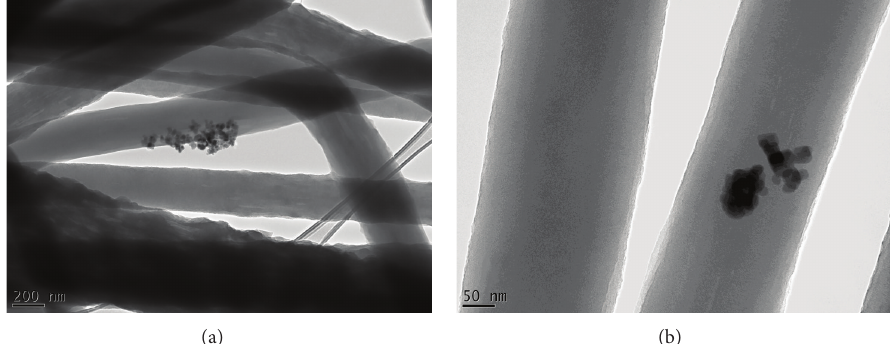
Figure 2: TEM images of PVdF/5 wt% Fe 3 O 4 fibres. (a) Protruding Fe 3 O 4 nanoparticle agglomeration. (b) Internal Fe 3 O 4 nanoparticle